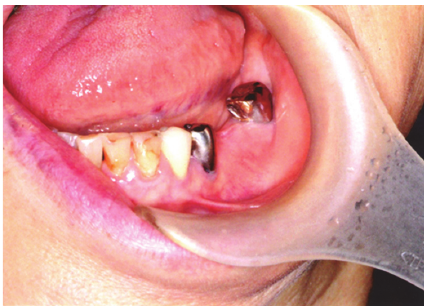
Figure 6: Intraoral photographic image taken 2 months after exfoli- ation. Epithelialization was observed, with no signs of inflammation in the surrounding mucosa.